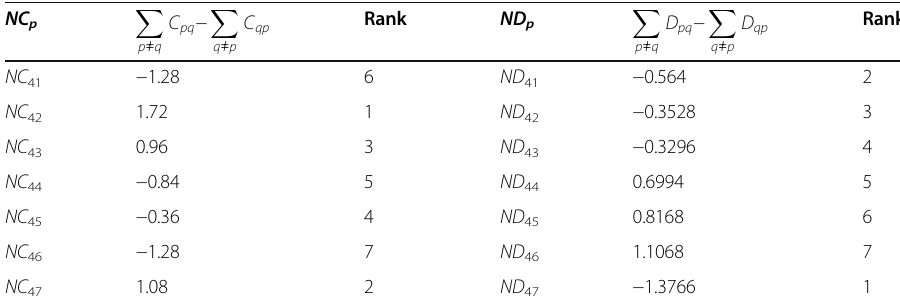
Table 15 Net concordance and discordance indices